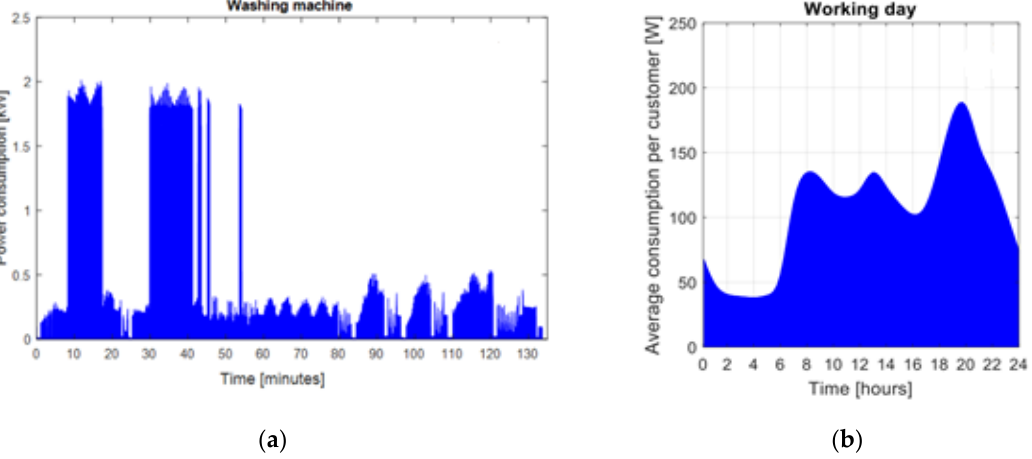
Figure 3. Examples of power consumption profiles: ( a ) a washing machine; ( b ) aggregated residential users on a working day (adapted with permission from ref. [28]).